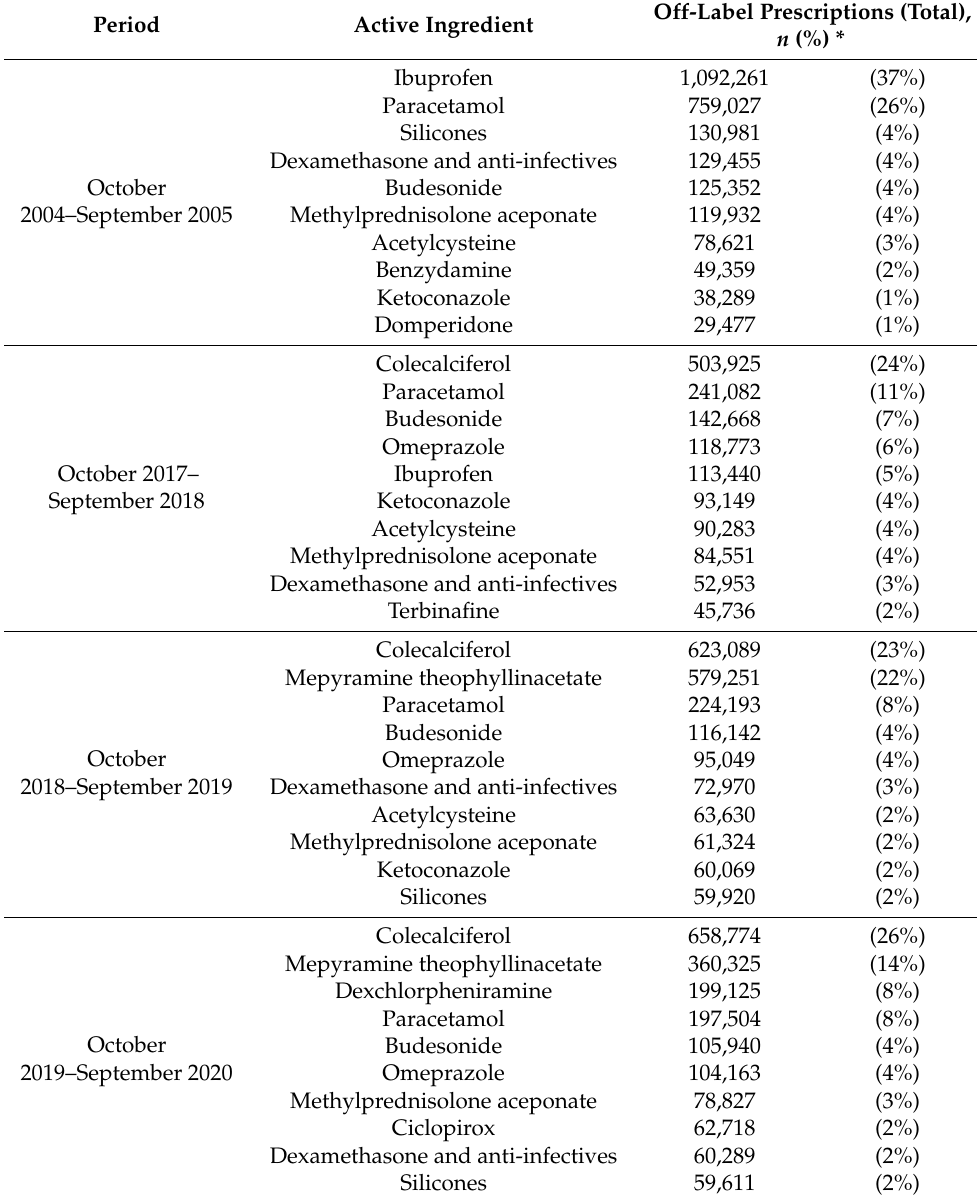
Table 4. Number of off-label prescriptions for the top 10 most-prescribed active ingredients per study period in the under-18